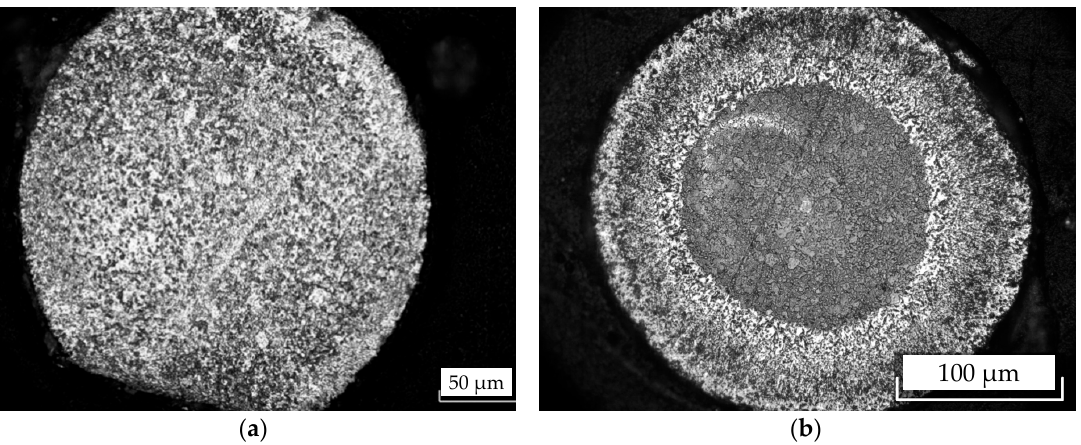
( b ) Figure 5. Microimages of a goffered molybdenum plate cross ‐ section: ( a ) an original substrate after cross ‐ section preparation and its etching; ( b ) after electrolysis. The cross ‐ section consists of two external zones (30 μ m + 30 μ m) and an internal zone 50 μ m thick (Figure 5b). XRD of goffered and crushed plates shows the presence of only one phase of molybdenum semi ‐ carbide, and therefore the zones differ only in structure. Full carburization of the goffered plate was confirmed by microanalysis. After deposition of the coating, the sample thickness became 110 μ m. 3.5. Microstructure of Molybdenum Wire before and after Electrodeposition The microstructure of the cross ‐ section of the original 250 μ m thick molybdenum wire is shown in Figure 6a. After electrolysis, the thickness of the samples reached 270–280 μ m, i.e., the increase is